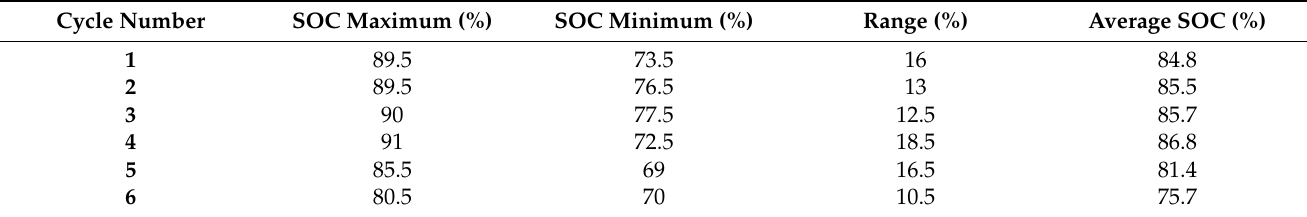
Table 5. Power battery SOC of vehicle B under 6 consecutive CLTC-P conditions.